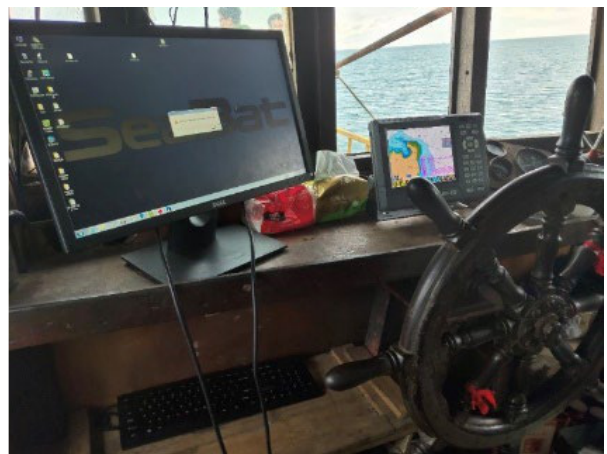
Figure 3. Multibeam bathymetry system. Table 2. The parameters of RESON SeaBat 7125 multibeam sounding system.